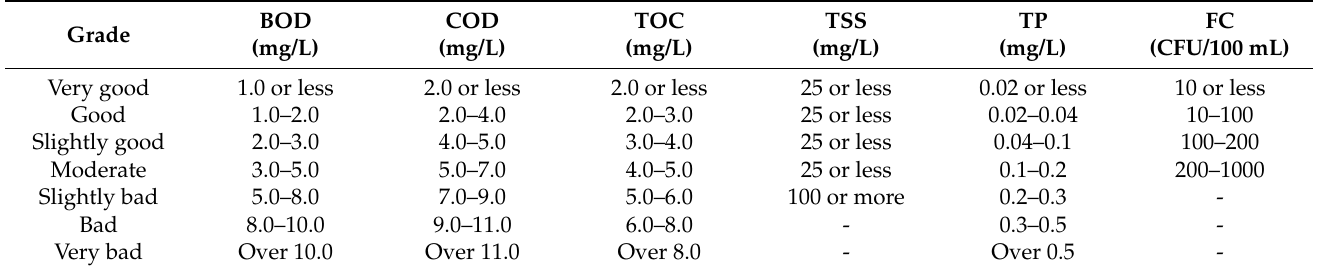
Table 4. Environmental standards for river water quality in Korea [50].